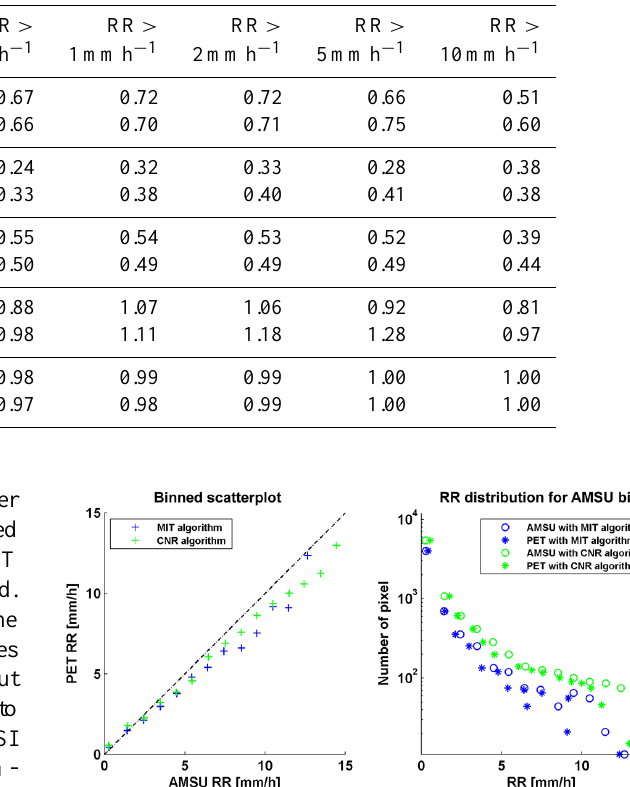
Table 4. Dichotomous statistics results for all cases studies, obtained using both MIT and IMAA-CNR algorithms for PM precipitation retrieval.